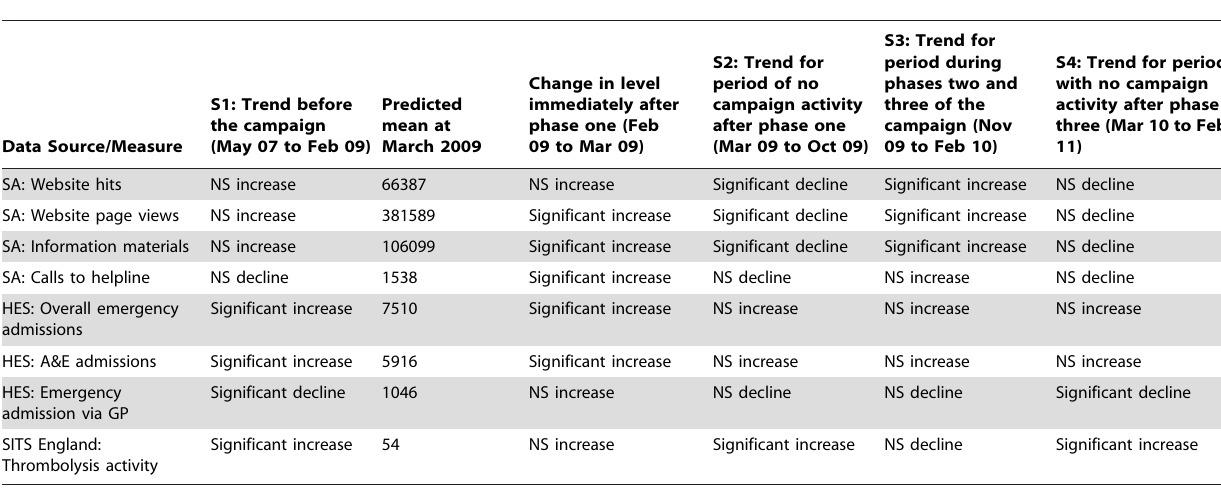
Table 2. Summary of statistically significant (p , 0.5) changes in data for different time periods.